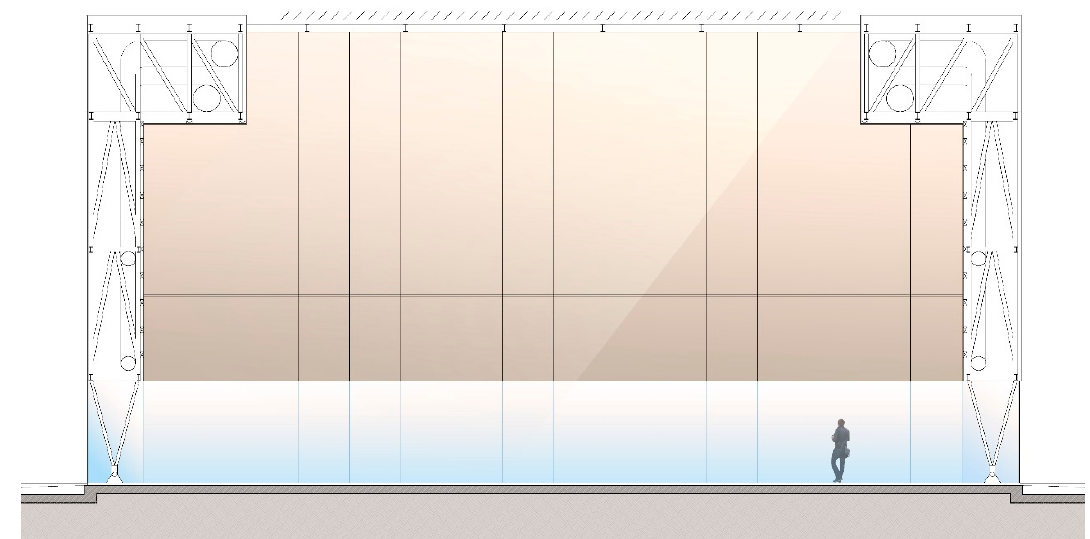
Figure 4. Cross section of the MUA, with passageway spaces in the enclosure.